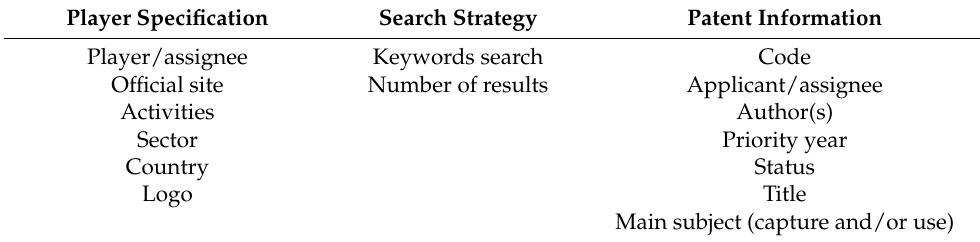
Table 4. Topics selected for bibliometric analyses of